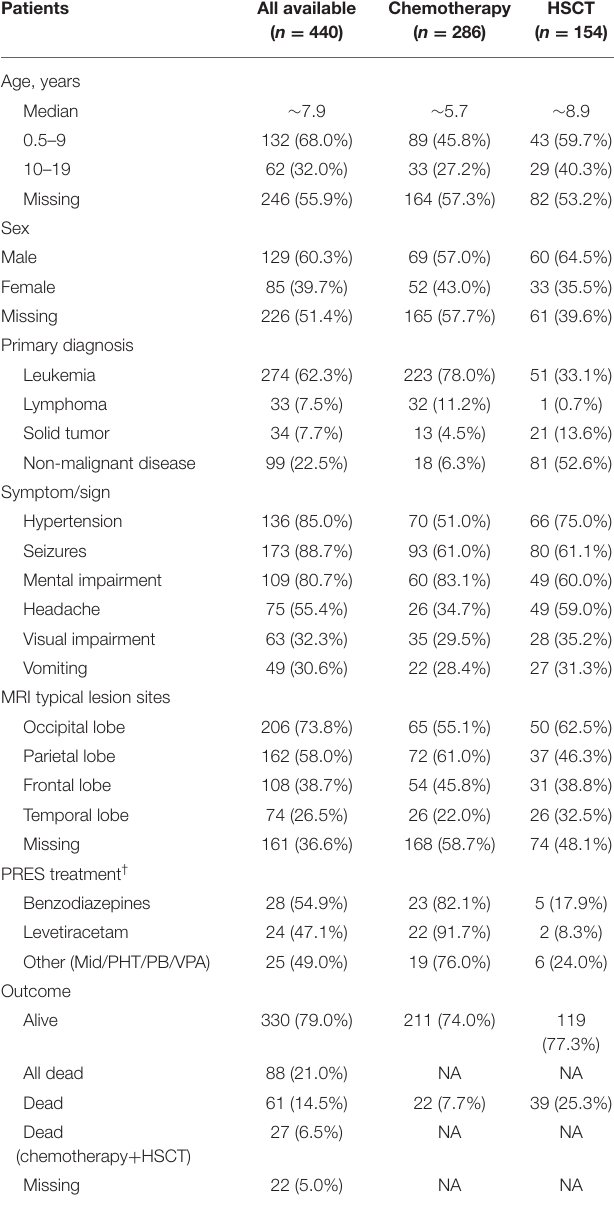
TABLE 4 | Comparison of demographic and clinical characteristics and outcomes of PRES patients with pediatric oncologic/hematologic diseases treated with chemotherapy vs.